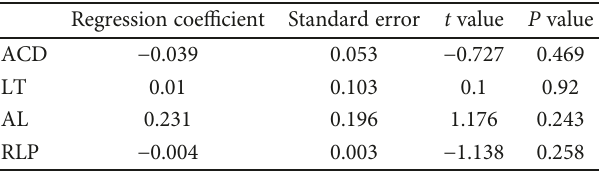
Table 2: Mixed linear regression model of ocular biometry in the CPACG associated with RP and CPACG groups.